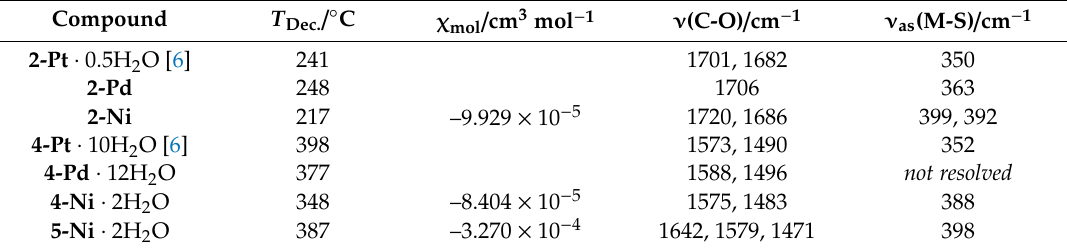
Table 1. Selected characterization data for [M(H 2 L) 2 ] ( 2 ), Zn 2 [M(L) 2 ] ( 4 and 5 ; M = Ni, Pd,